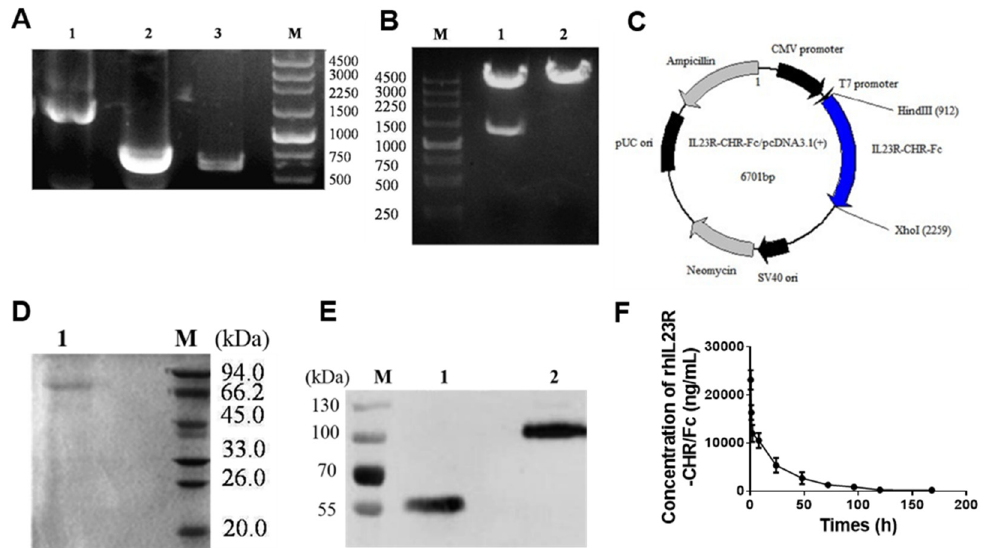
Figure 1. Construction, expression, and purification of rhIL-23R-CHR / Fc. ( A ) PCR products of rhIL-23R-CHR / Fc recombinant gene. Lane 1, rhIL-23R-CHR / Fc gene sequence. Lane 2, hIgG1 Fc fragment. Lane 3, rhIL-23R-CHR gene. M, DNA molecular weight markers, bp. ( B ) Identification of rhIL-23R-CHR-Fc / T vector digested by Hind III and Xho I sites. Lane 1, pcDNA3.1 ( + ) - IL-23R-CHR / Fc after digestion. Lane 2, pcDNA3.1 ( + ) - IL-23R-CHR / Fc before digestion. M, DNA marker, bp. ( C ) Plasmid map of pcDNA3.1 ( + ) - IL-23R-CHR / Fc. The gene sequence encoding rhIL-23R-CHR / Fc was inserted into pcDNA3.1 ( + ) vector at the corresponding restriction sites Hind III and Xho I. ( D ) SDS-PAGE analysis of the purified rhIL-23R-CHR / Fc fusion protein using Protein A column. Lane 1, purified rhIL-23R-CHR / Fc fusion protein at reduced state. M, protein molecular weight markers, KDa. ( E ) Western blot analysis of rhIL-23R-CHR / Fc using mAbs against human IL-23R. Lane 1, purified rhIL-23R-CHR / Fc fusion protein at non-reduced state. Lane 2, purified rhIL-23R-CHR / Fc fusion protein at reduced state. ( F ) Plasma clearance of IL23RCHR-Fc in mice.